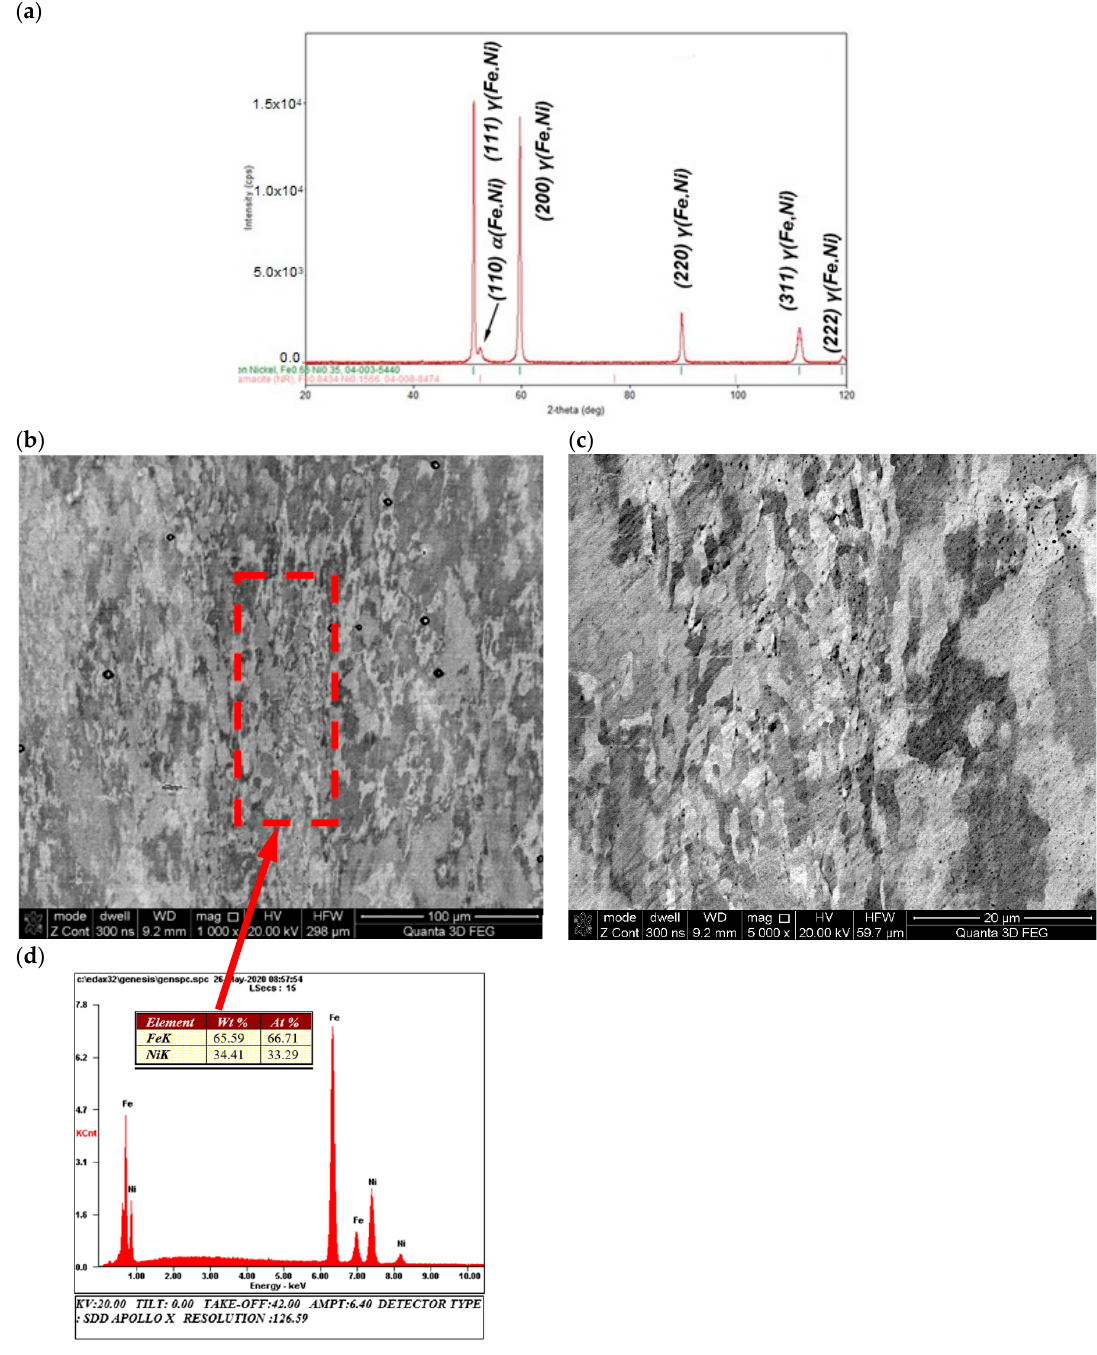
Figure 5. XRD patterns of ( a ) austenitic γ (Fe, Ni) with trace amounts of ferrite α (Fe, Ni) structure of Fe65Ni35 sample ( b ) after supersaturation from 340 °C (SEM/BSE) with ( c ) visible bimodal morphology of fine-grained structure (SEM/BSE) and ( d ) microanalysis results of chemical composition from area marked in ( b ).